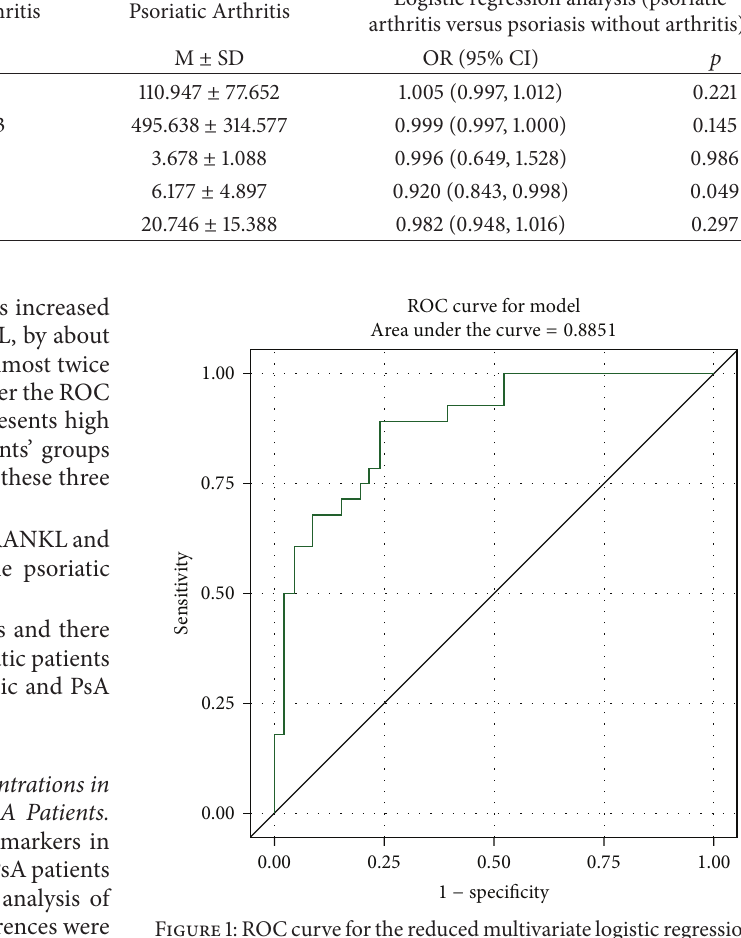
Table 3: The biomarkers serum concentrations in the psoriatic patients with and without arthritis. Biomarker